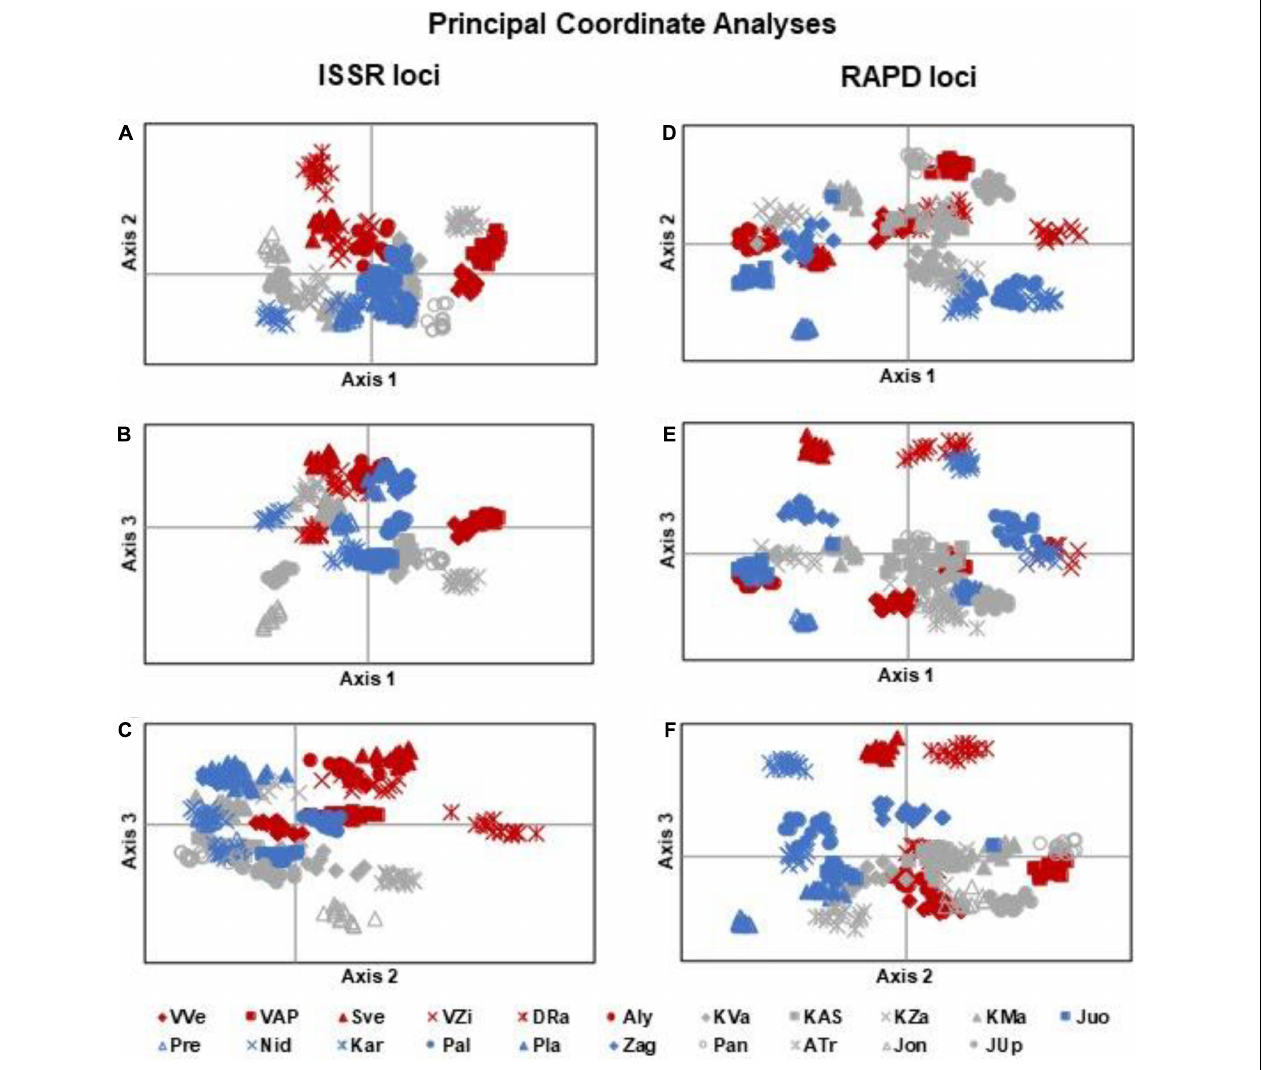
FIGURE 5 | Principal coordinate analyses of Impatiens parviflora individuals of 21 populations according to: (A–C) ISSR loci, (A) – axis 1 vs. 2, (B) – axis 1 vs. 3, (C) axis 2 vs. 3; (D–F) RAPD loci, (D) – axis 1 vs. 2, (E) – axis 1 vs. 3, (F) – axis 2 vs. 3. Color of the labels denotes location of populations: blue – North-West, gray – Central, and red – South-East part of the